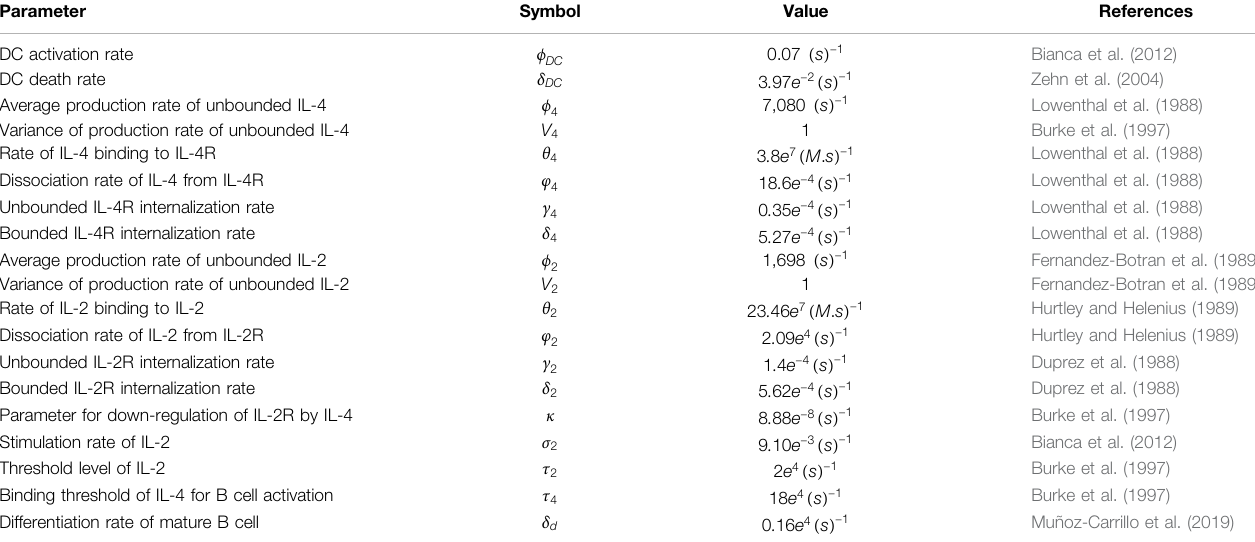
TABLE2| ParametervaluesParametersinvolvedin Eqs2 – 10 describingeffectsofIL-2andIL-4ontheproliferationofT,B,andPlasmaBcellsinresponsetotheinvasionof pathogens. All values present in this table are collected from published results of in-vitro or in-vivo experimental research.